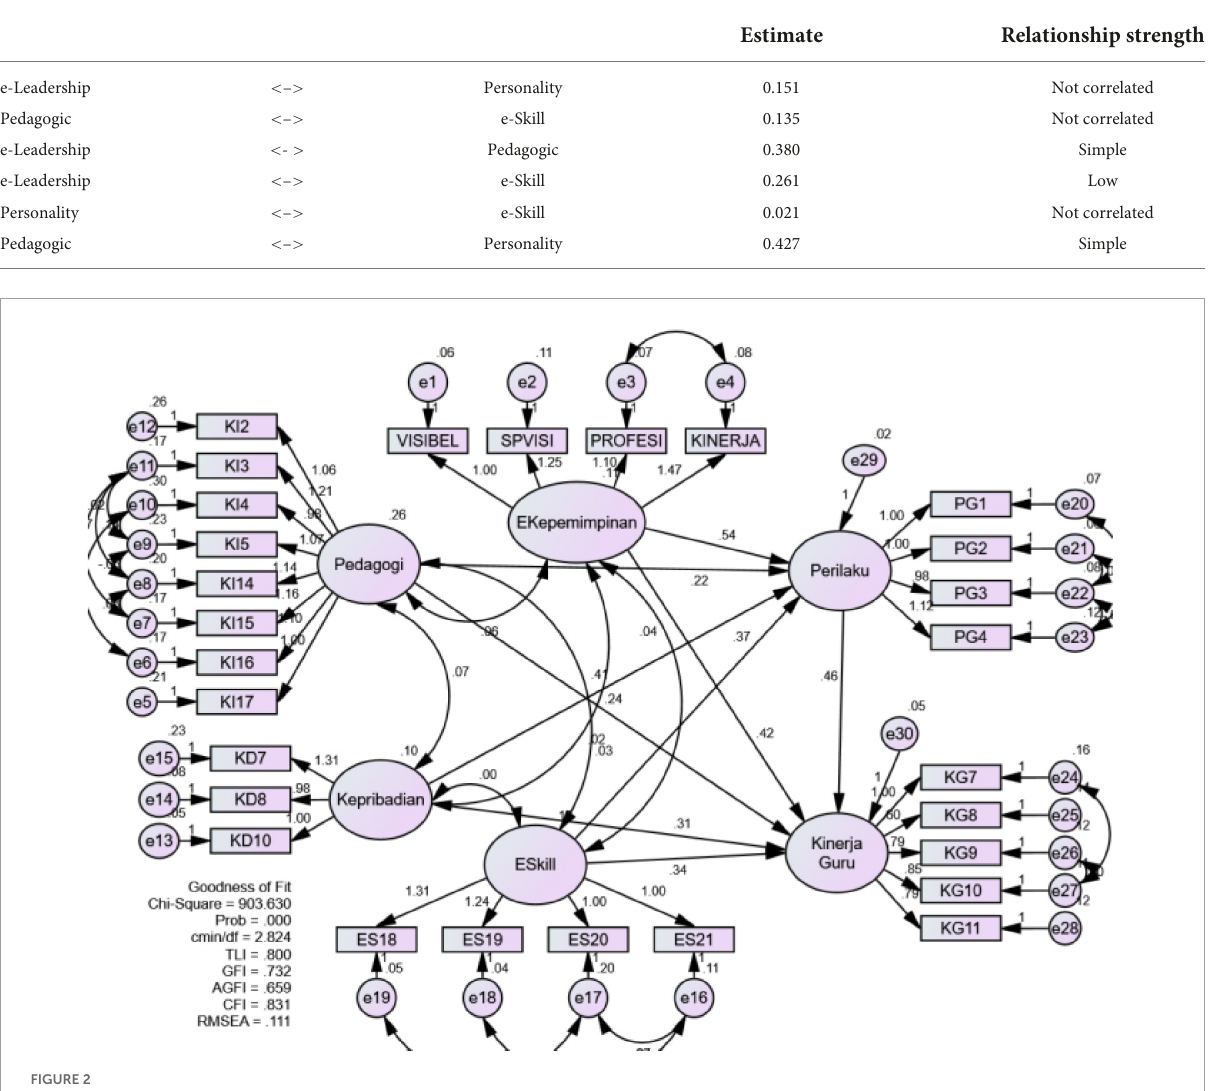
FIGURE2 Diagram of GOF (Goodness of fit) test analysis results.